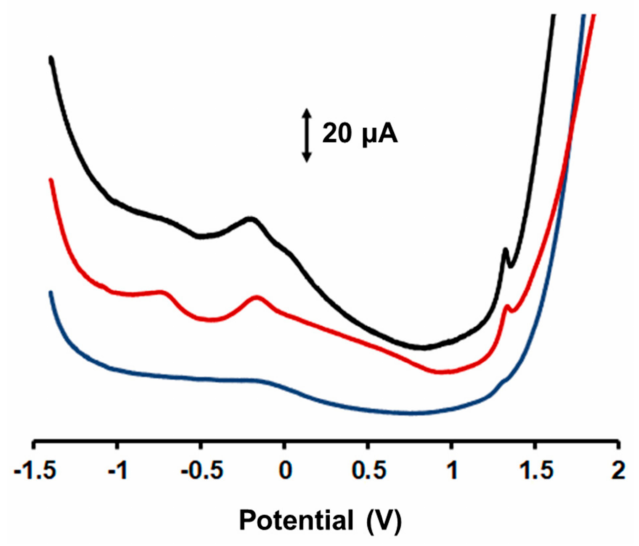
Figure 4. DP voltammograms of 0.6 mM GLU in 0.10 M phosphate buffer, pH 6.0 at the modified GPEs loaded with 1% (black line), 2% (red line), and 5% (blue line) w / w 3D-Fe-MOF .